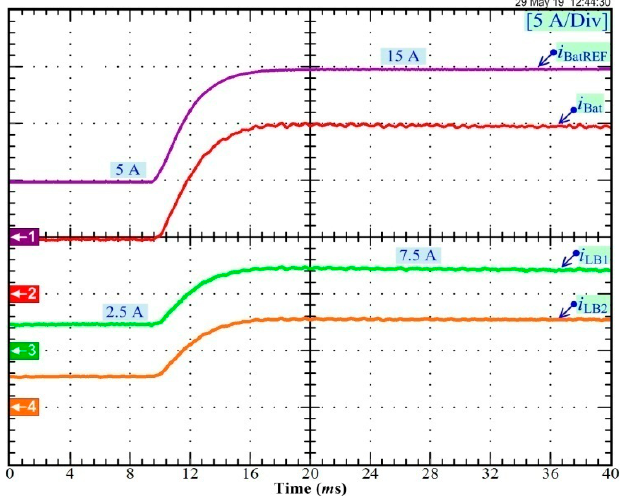
Figure 9. Experimental results: battery current response during i BatREF changing from 5A to 15 A.